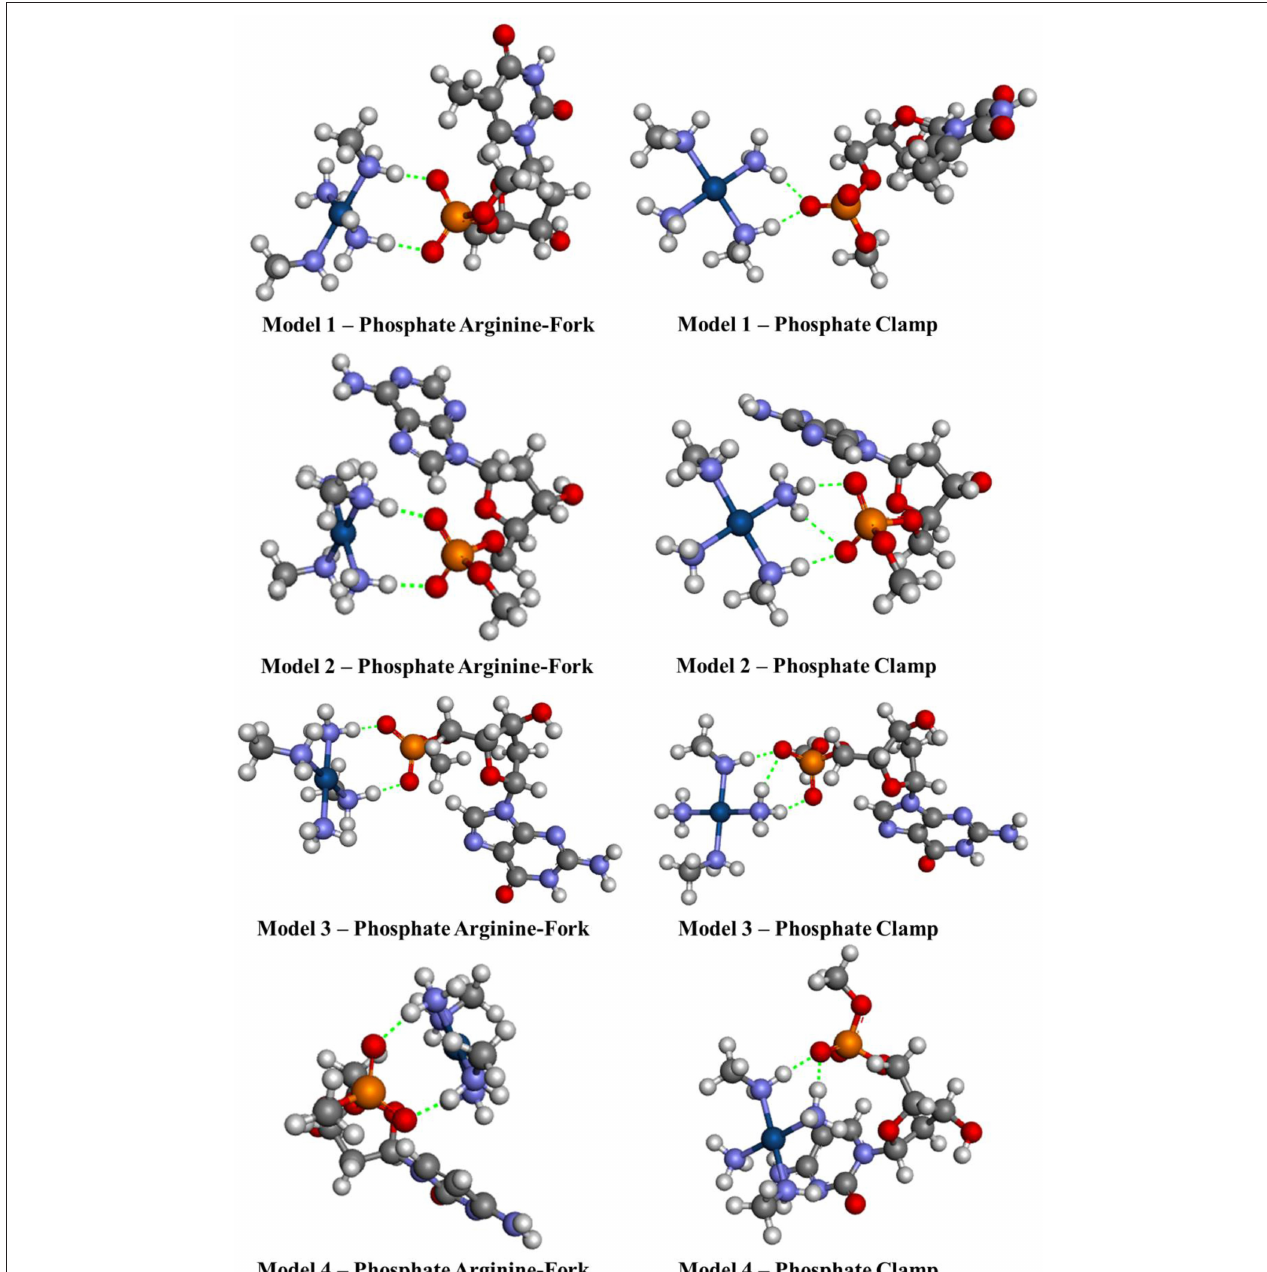
FIGURE 7 | Optimized structures of each different phosphate models 1–4 using the BHandH functional.